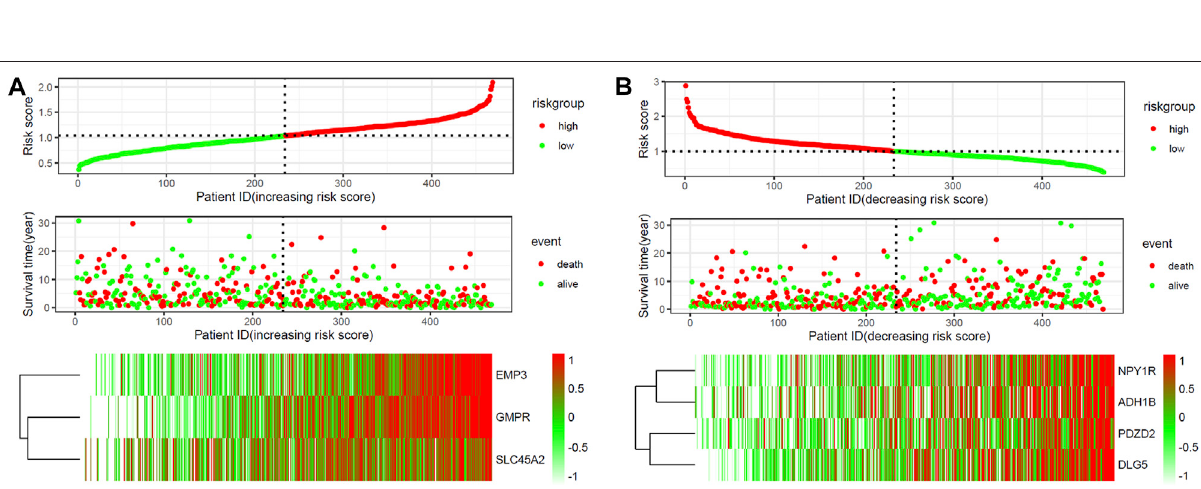
Frontiers in Cell and Developmental Biology |